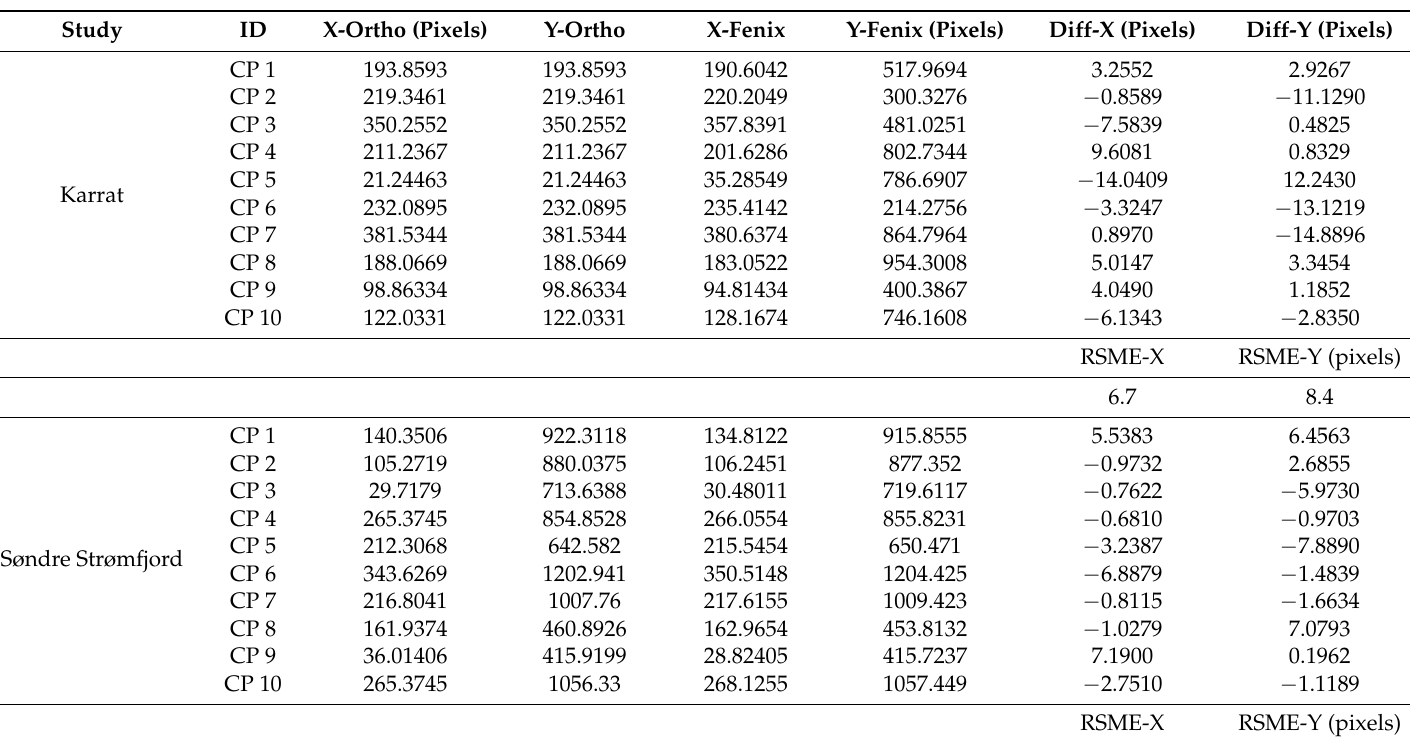
Table 1. Quantitative evaluation of the registration accuracy using handpicked control points from the pseudo-orthophotos. Coordinates for the CPs are assessed against the corresponding coordinates in reconstructed hyperspectral data along X and Y